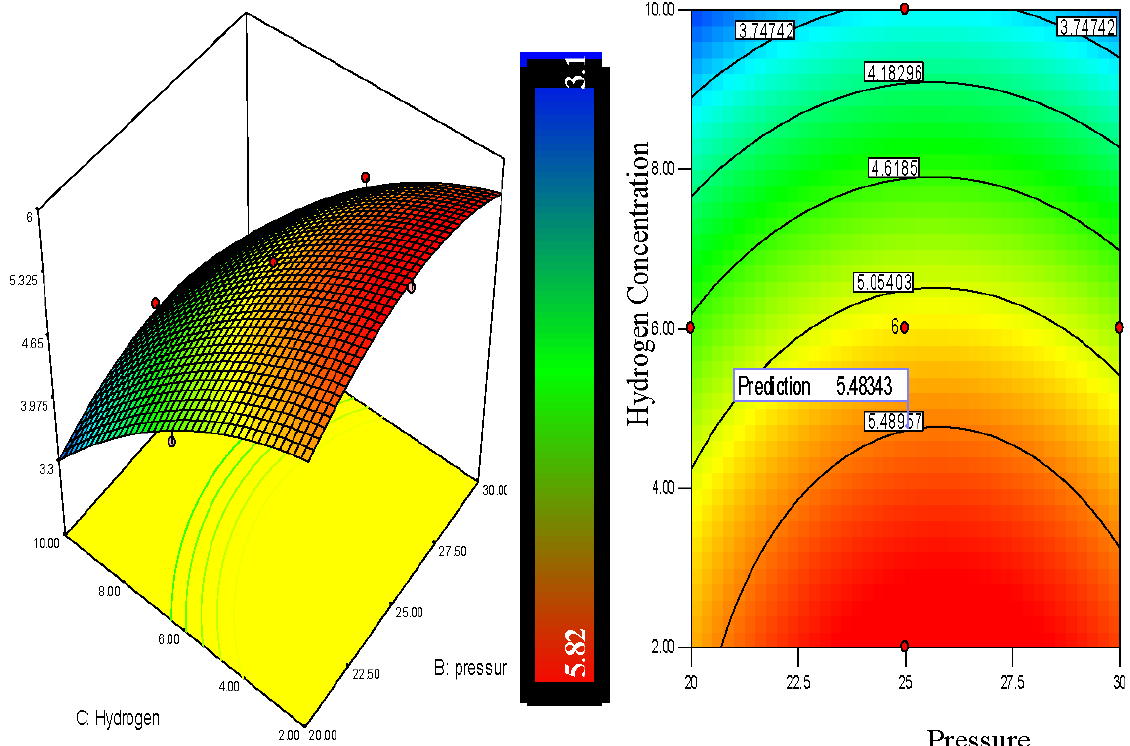
Figure 8. 3D Response surface and contour plot of hydrogen concentration vs. pressure on polypropylene production